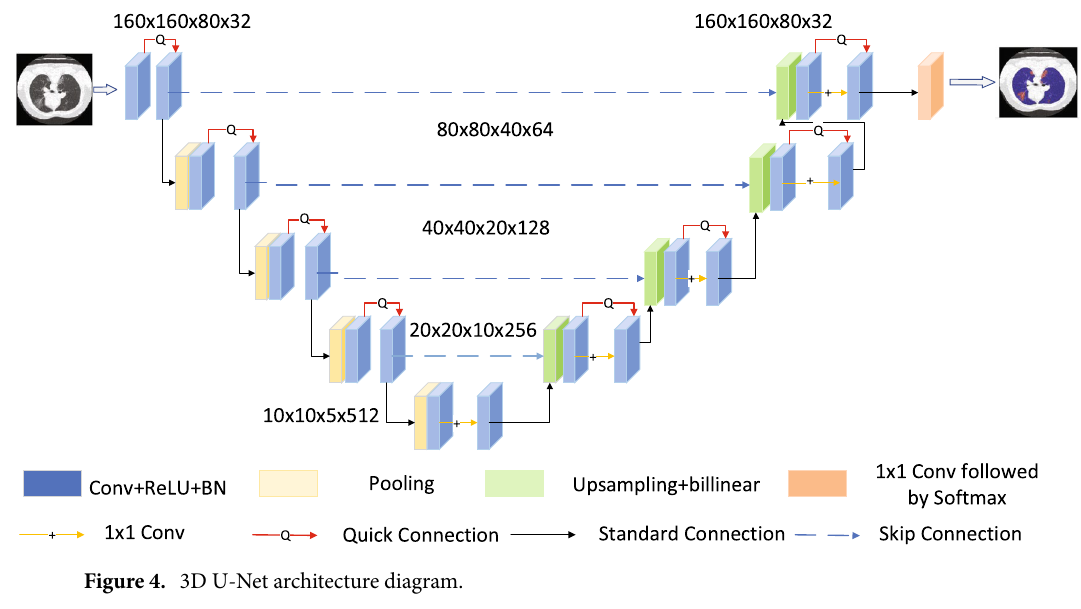
Figure 4. 3D U-Net architecture